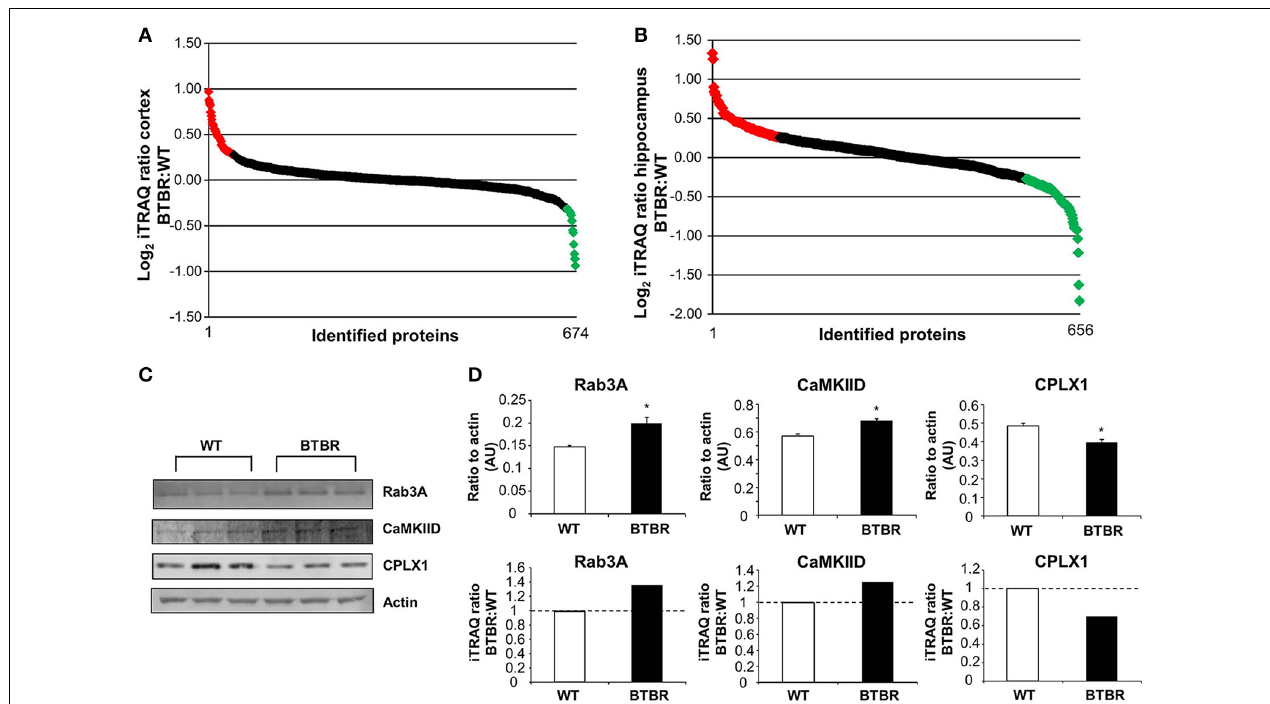
FIGURE 4 | Quantitative proteomic and bioinformatics analysis of BTBR CNS tissues. Log 2 transformed iTRAQ ratio data (BTBR:WT) snake plot of the proteins identified in the cortex (A) and hippocampus (B) are depicted. Upregulated proteins are highlighted in red, while downregulated proteins are